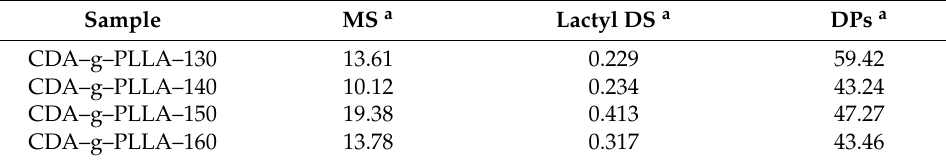
Table 1. Compositional parameters of CDA–g–PLLA graft